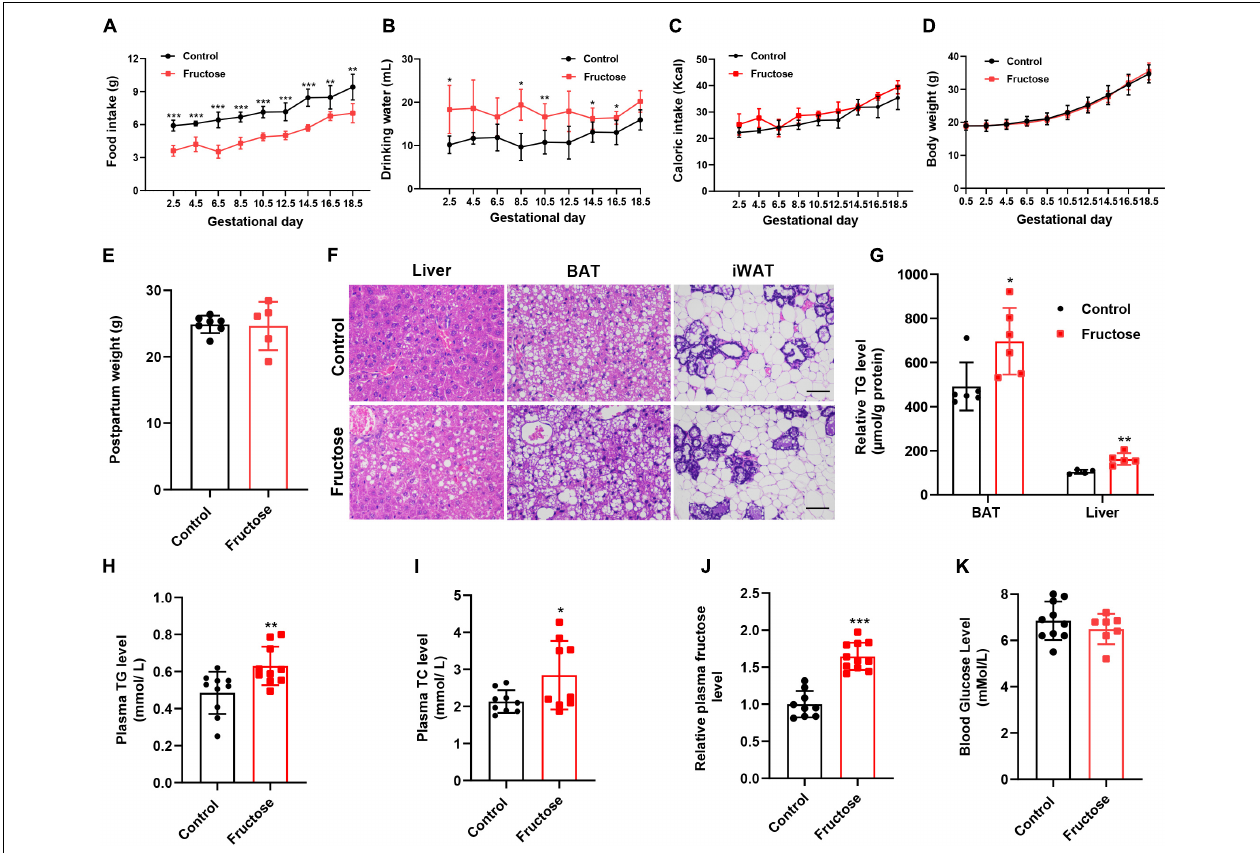
FIGURE 1 | High-fructose intake during pregnancy does not alter body weight but causes slight lipid metabolic disorders in female mice. (A–C) Daily food intake, drinking water consumption, and total caloric intake of the control pregnant mice and the high-fructose-fed pregnant mice during the period of gestation ( n = 5–6). (D) Bodyweight of the control pregnant mice and the high-fructose-fed pregnant mice during the period of gestation ( n = 7–10). (E) Postpartum weight of the control pregnant mice and the high-fructose-fed pregnant mice ( n = 5–7). (F–K) All data were from control pregnant mice and the high-fructose-fed pregnant mice at day 18.5 of pregnancy. Mice fasted for 4–6 h before sacrifice. (F) H&E staining of paraffin sections of liver, brown fat tissue (BAT), and inguinal white fat tissue (iWAT). Scale bar, 50 µ m for liver and BAT, 100 µ m for iWAT. (G) Quantification of triglyceride content in liver and BAT ( n = 4–6). (H,I) Plasma concentrations of triglyceride (TG) and total cholesterol (TC) ( n = 9–10). (J) Relative fasting plasma fructose level ( n = 11). (K) Fasting blood glucose level ( n = 7–10). * p < 0.05, ** p < 0.01, *** p <